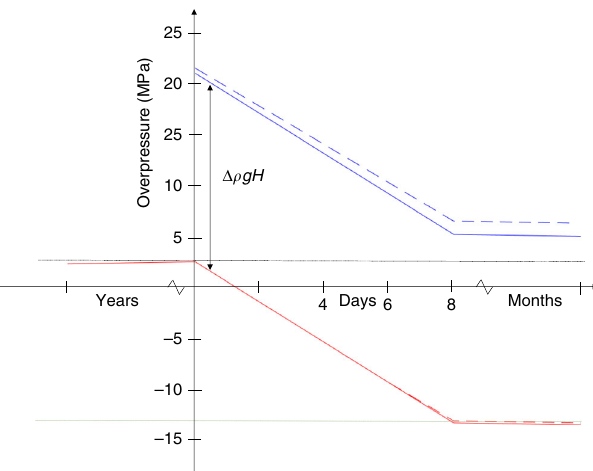
Fig. 5 Excess pressure in a magma plumbing system. Pressure history during in fl ation and de fl ation. Combined overpressure from magma fl ow and buoyancy pressure in a magma body (red, solid line considering a constant magma density and dashed line taking into consideration the magma density changes induced by gas exsolution) and in a location higher within a sustained magma channel (blue, solid line considering a constant magma density and dashed line taking into consideration the magma density changes induced by gas exsolution). The two curves are separated by Δ ρ gH (which is a constant value when volatiles are not considered). Note that volatiles are not expected to in fl uence the overpressure evolution for a magma body located at 8 km or larger depth. Gas exsolution may cause the two curves to slightly diverge as de fl ation evolves, as such a process will always have a larger in fl uence at shallower depth. Failure of the magma body occurs at t = 0 and caldera collapse (failure of caldera faults) begins in this example at day 8 after the failure of the magma body. For a long time prior to that (years), the pressure conditions are close to the magma body failure limit due to magma buoyancy. Overpressure in the magma body is limited according to the general failure criterion, here considered to correspond to be effective tensile strength of 2.5 MPa (black horizontal dotted line). In this example, slip on caldera ring faults begins at day 8 when critical conditions for caldera failure are reached (green horizontal line). Following that, there is small change in pressure as piston collapse drives out a large volume of magma over months. See text for